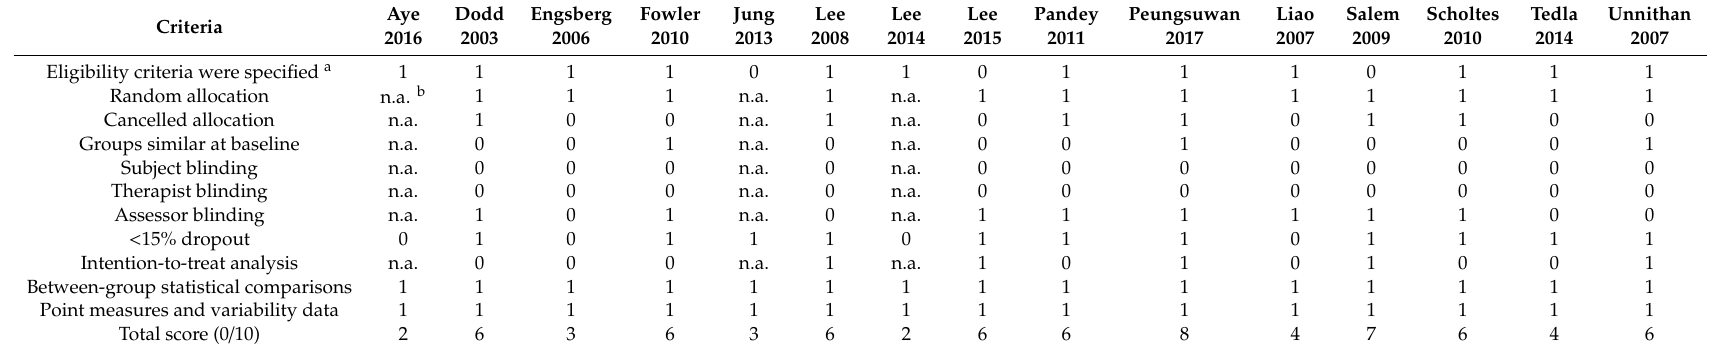
Table 3. Results of the quality assessment based on the Physiotherapy Evidence Database (PEDro) Scale, for the studies finally included.